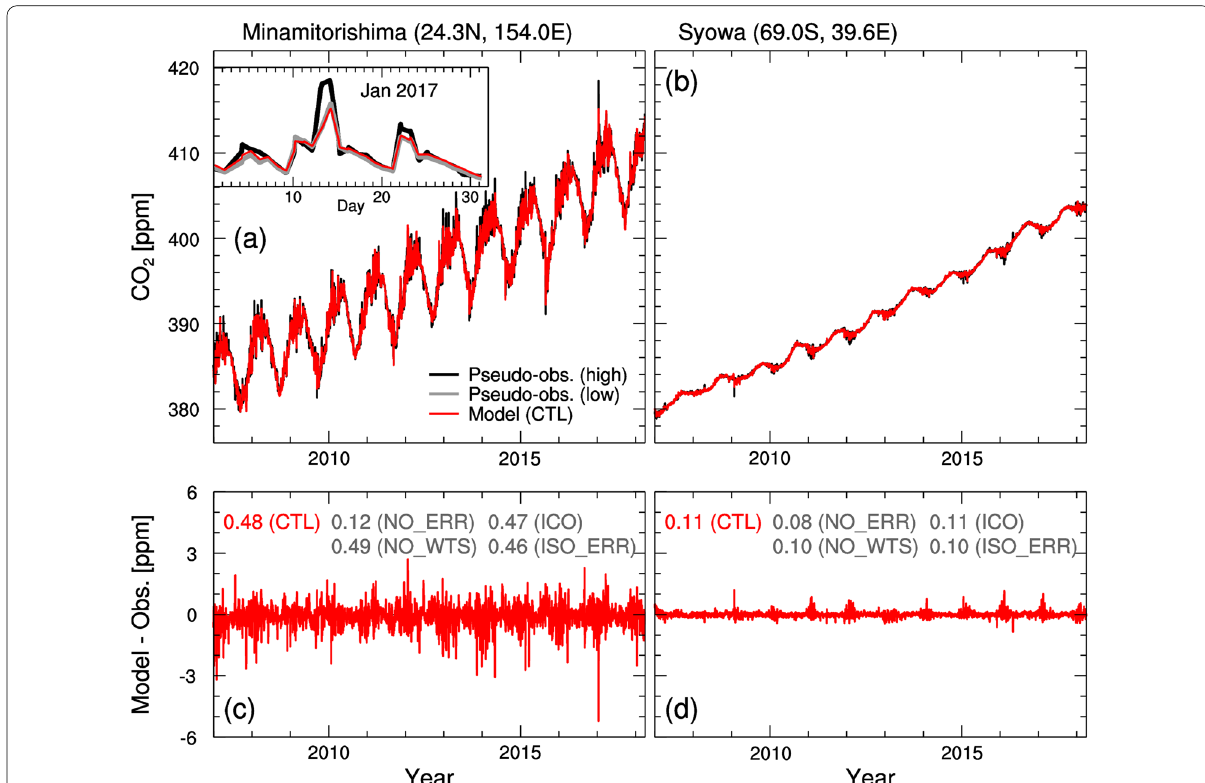
Fig. 5 Upper panels indicate the time series of CO 2 mole fractions at Minamitorishima (24.3° N, 154.0° E) ( a ) and Syowa Station (69.0° S, 39.6° E), Antarctica ( b ). Black and red lines represent the pseudo-observation and the model with the CTL posterior flux, respectively. The inset of panel ( a ) depicts the CO 2 mole fraction time series zoomed for January 2017, including the lower-resolution pseudo-observation (gray line). (The x-axis covers the whole period of January 2017, and the y-axis ranges from 406 to 420 ppm.) Lower panels indicate the differences between the CTL model and the pseudo-observation (model–observation) at Minamitorishima ( c ) and Syowa Station ( d ), where the number indicates the root-mean-square difference for each sensitivity experiment. Note that the NO_ERR case is compared with the pseudo-observations generated from the lower-resolution